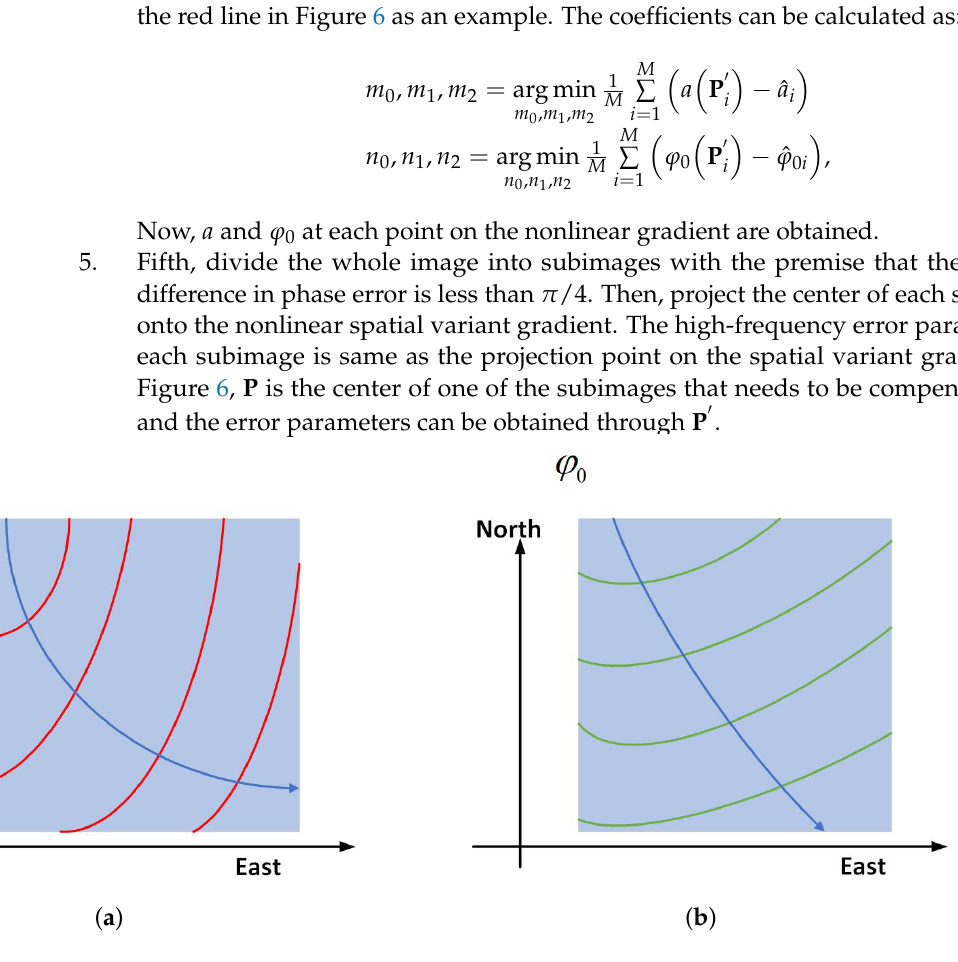
Figure 5. The contour and the nonlinear gradient of the amplitude a and initial phase ϕ 0 . ( a ) is the result of a . ( b ) is the result of ϕ 0